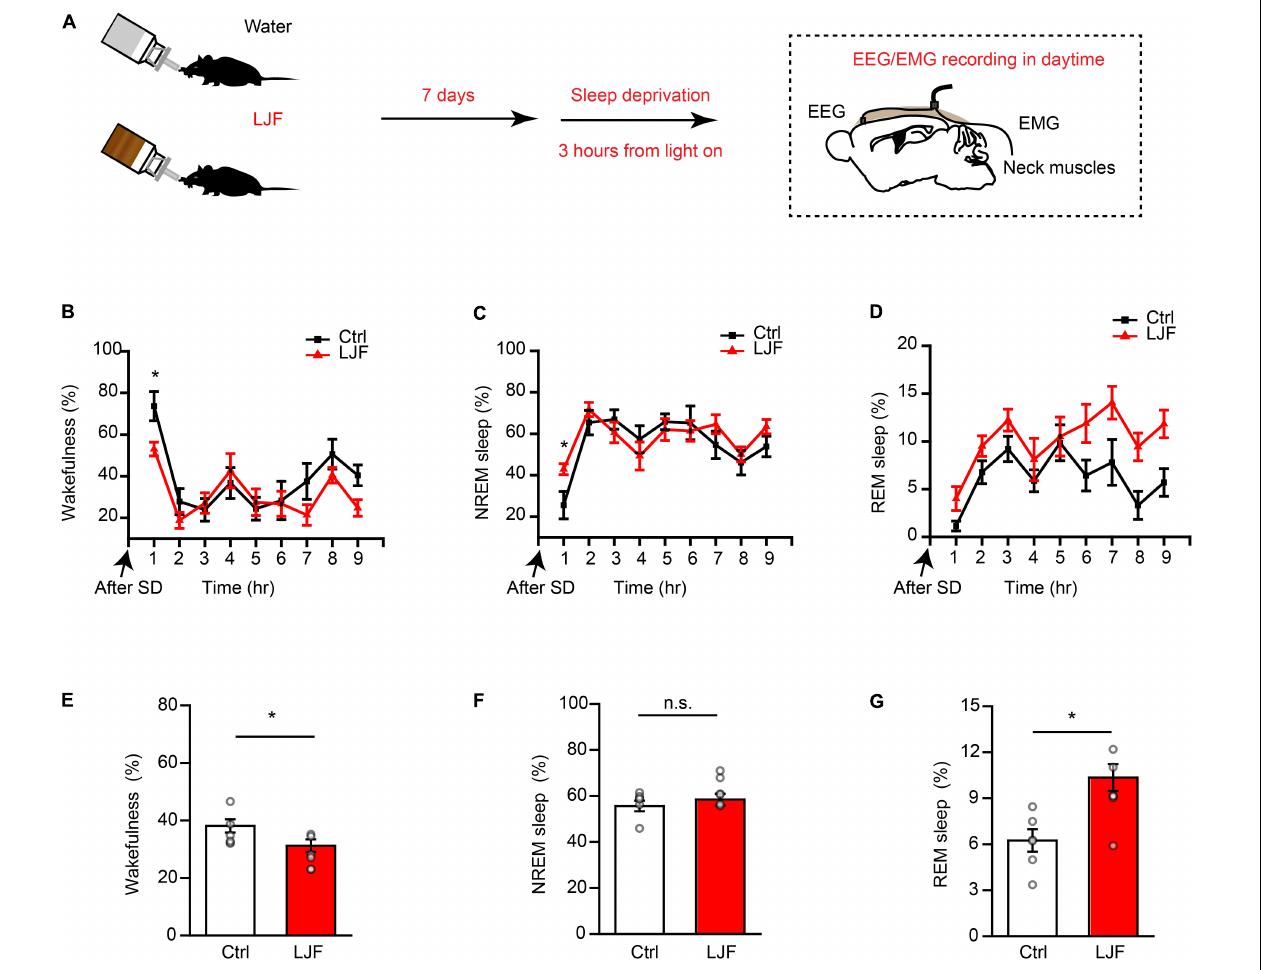
FIGURE 3 | Lonicerae Japonicae Flos (LJF) promotes homeostatic sleep in mice subjected to acute sleep deprivation. (A) The scheme of sleep recordings to analyze the effects of LJF in acute sleep-deprived mice. (B–D) Time spent by the control and LJF-treated mice in (B) wakefulness, (C) NREM sleep, and (D) REM sleep after 3 h sleep deprivation. (E–G) Histogram plots show the time spent by control and LJF-treated mice in (E) wakefulness, (F) NREM sleep, and (G) REM sleep over a period of 9 h after sleep deprivation. Each gray dot represents a single mouse. The data are expressed as means ± S.E.M. n = 6 per group; two-tailed unpaired t -test was used to compare the data; * P < 0.05; n.s., no